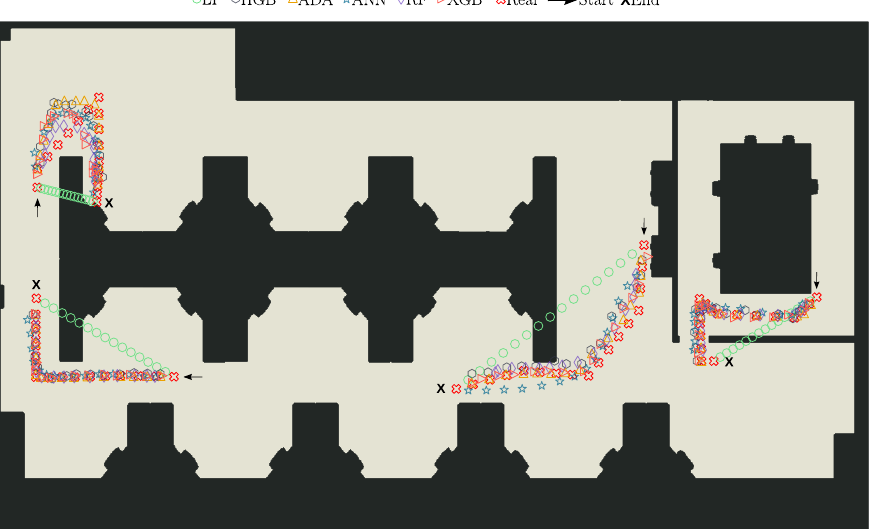
Figure 3. This Figure represents the floor plan of a real environment. The arrow and black X indicate the start and end point of the path, respectively. The red X’s represent the real coordinates. The green circles, gray hexagons, yellow triangles, blue stars, purple diamonds, and orange rotated triangles correspond to the predictions of LI, Histogram-Based Gradient Boost, Ada Boost, ANN, Random Forest, and XGBoost,